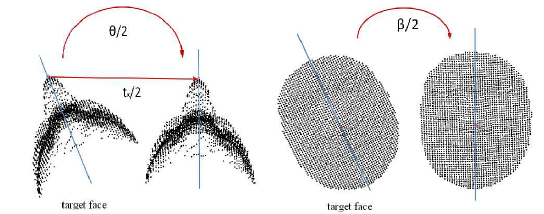
Fig. 10. Rotations along y-axis(left figure) and z-axis(right figure) from the target face to model face(mirror face).